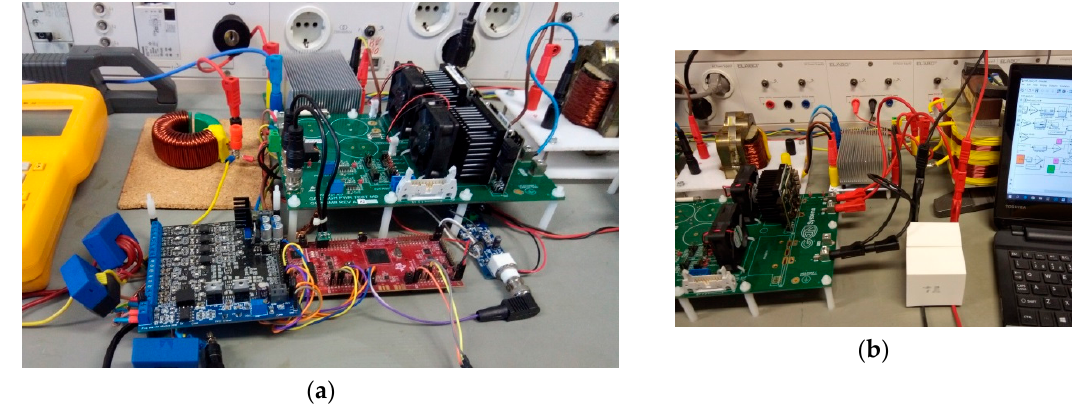
Figure 7. Experimental prototype workbench: ( a ) the main primary side; ( b ) secondary side.